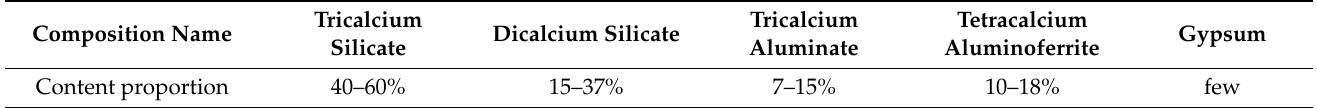
Table 1. The main mineral compositions of PO42.5 cement (provided by